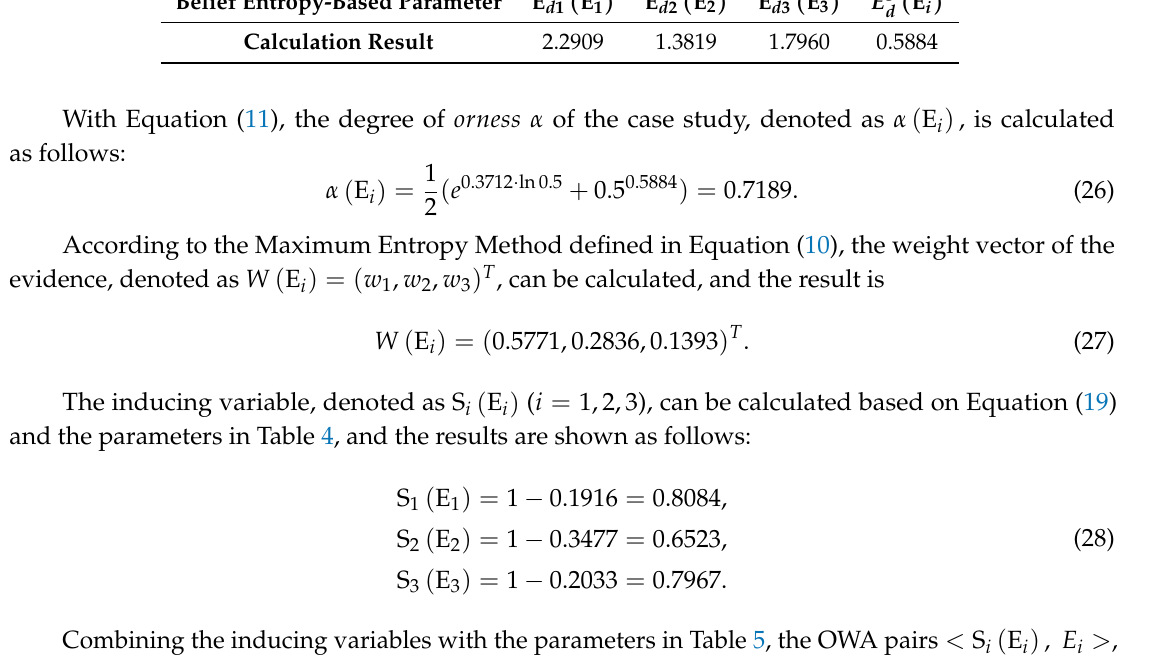
Table 5. The belief entropy and global belief entropy of E i ( i = 1,2,3). Belief Entropy-Based